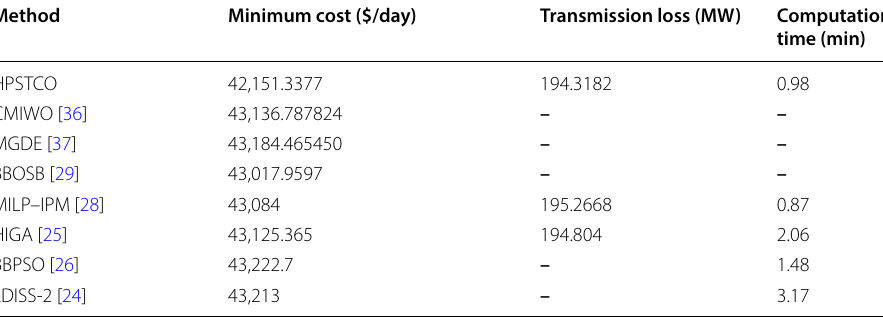
Table 6 Comparison (of cost and computation time) with other hybrid